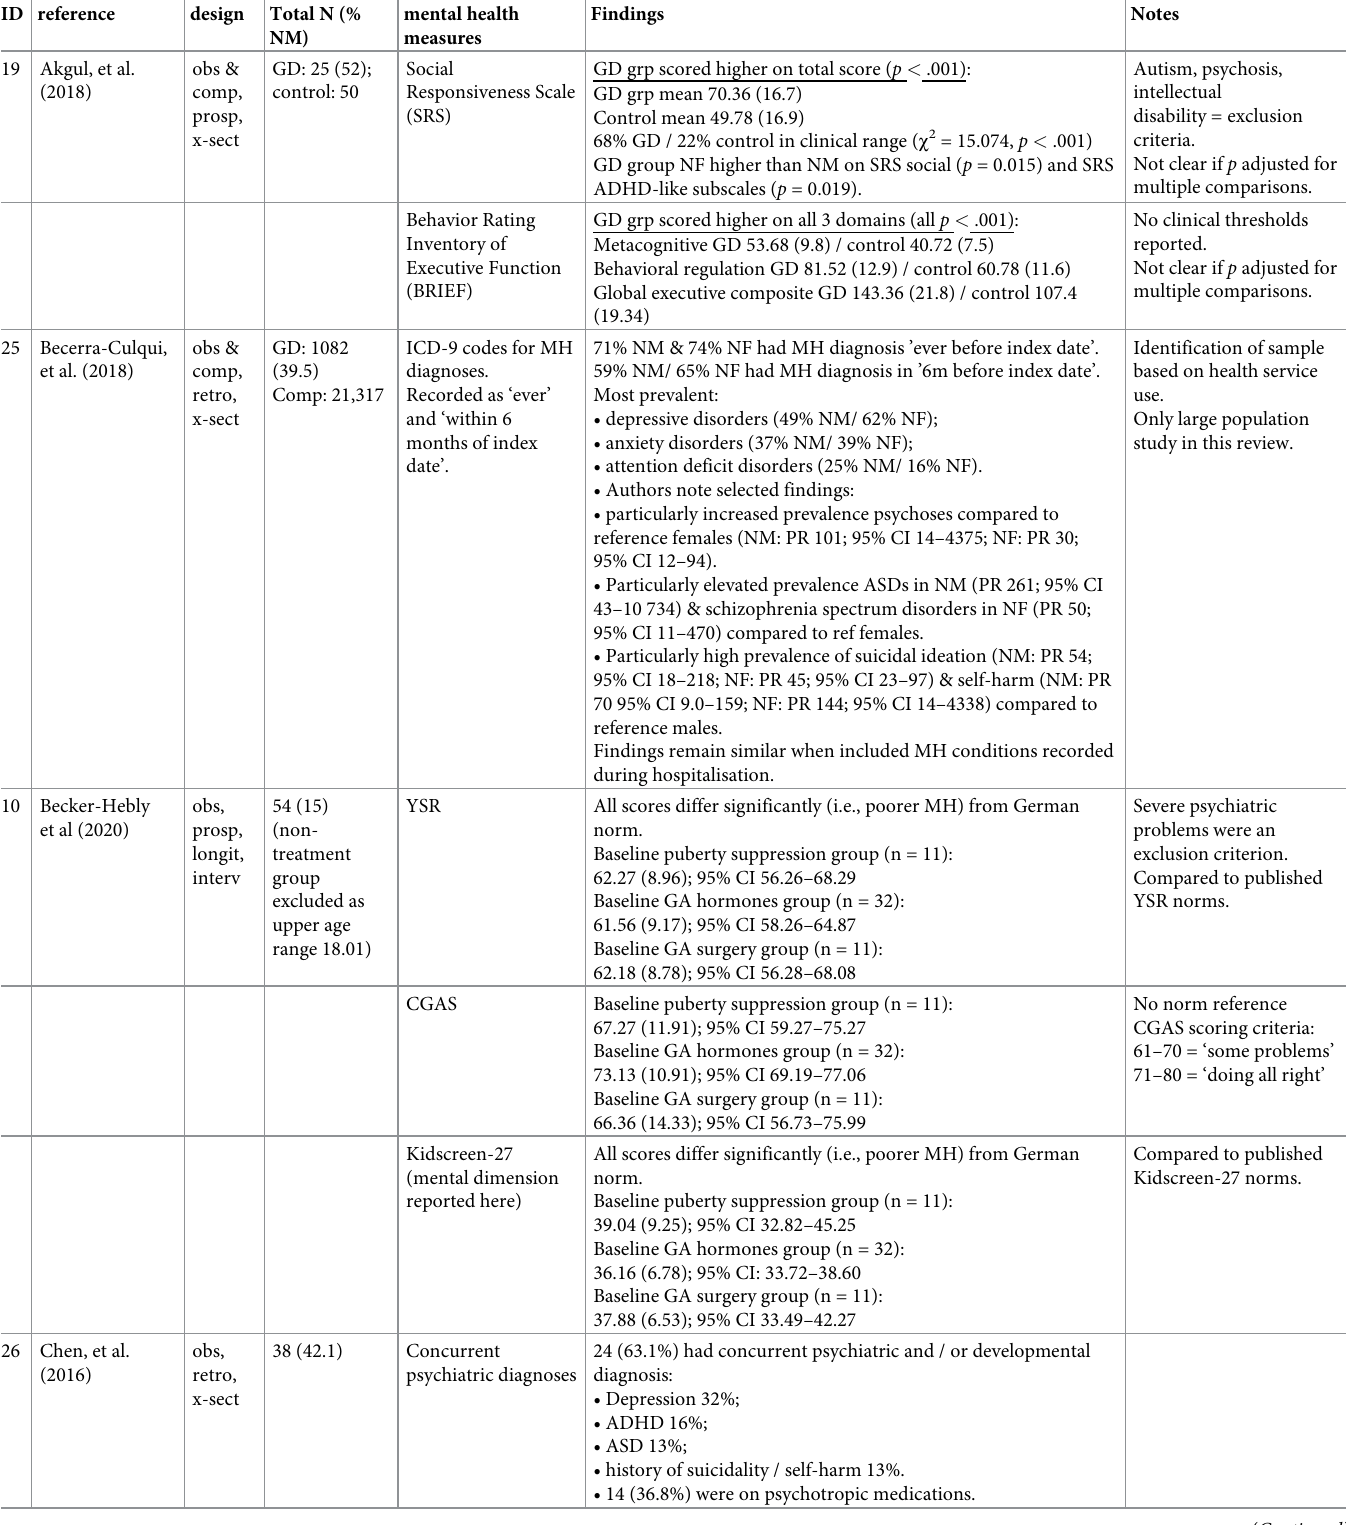
Table 4. Mental health and cognitive status associated with